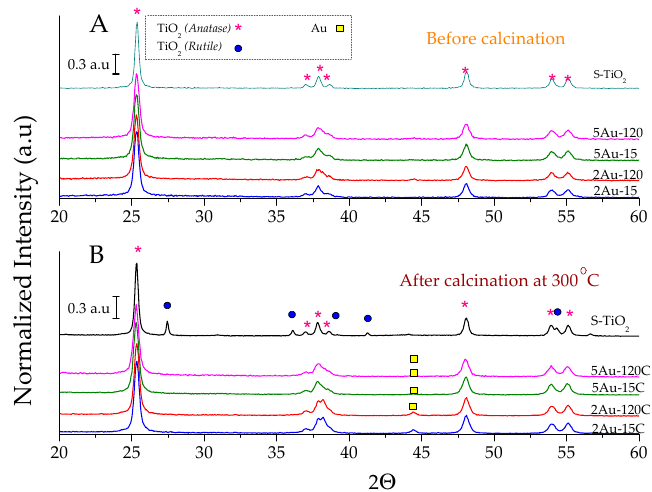
Figure 1. XRD patterns of the prepared materials: ( A ) before calcination at 300 ◦ C; ( B ) after calcination at 300 ◦ C.